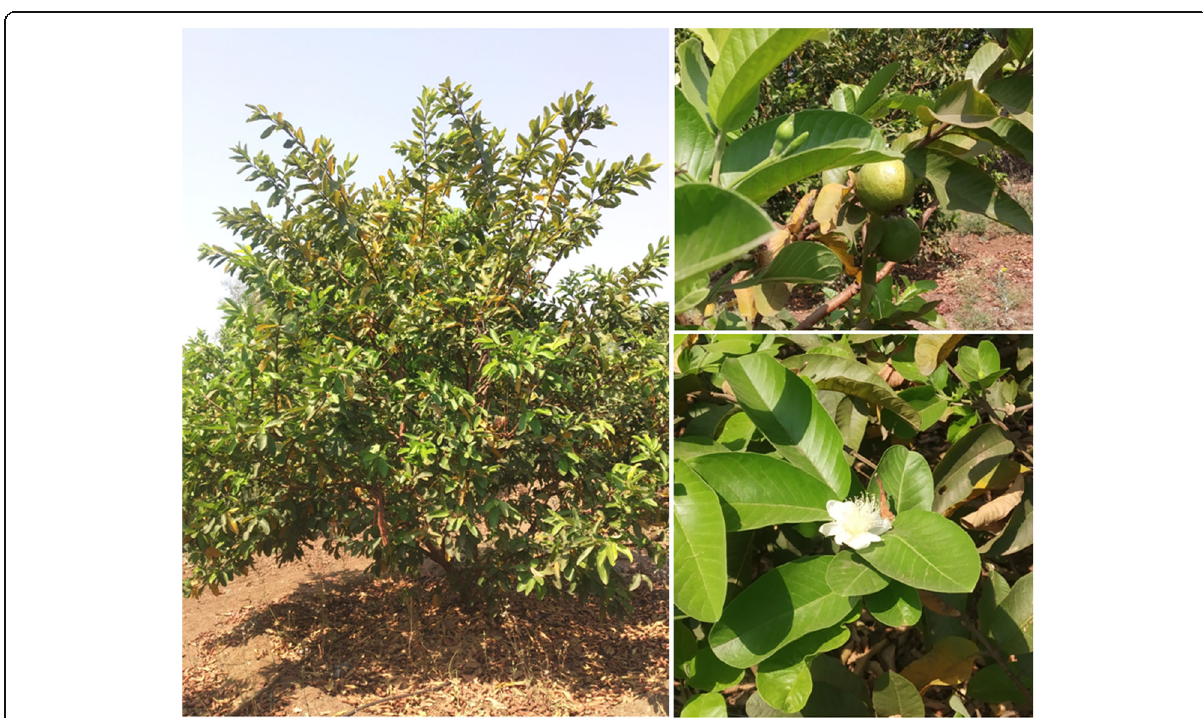
Fig. 1 Psidium guajava plant in its habitat, with few fruits and flowers